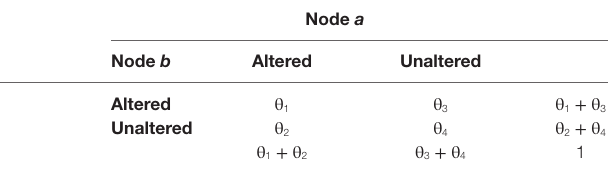
Table 2 | Marginal probabilities between altered and unaltered